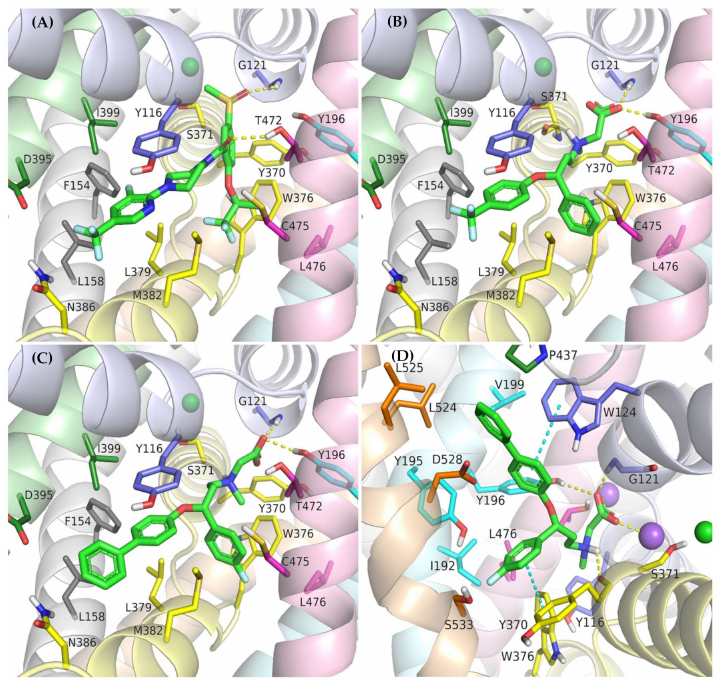
Figure 5. Binding mode of the noncompetitive GlyT-1 inhibitors within the transporter in the inward- open state: bitopertin ( A ), ORG-24598 ( B ), ALX-5407 ( C ); and transporter in the outward-open state: ALX-5407 ( D